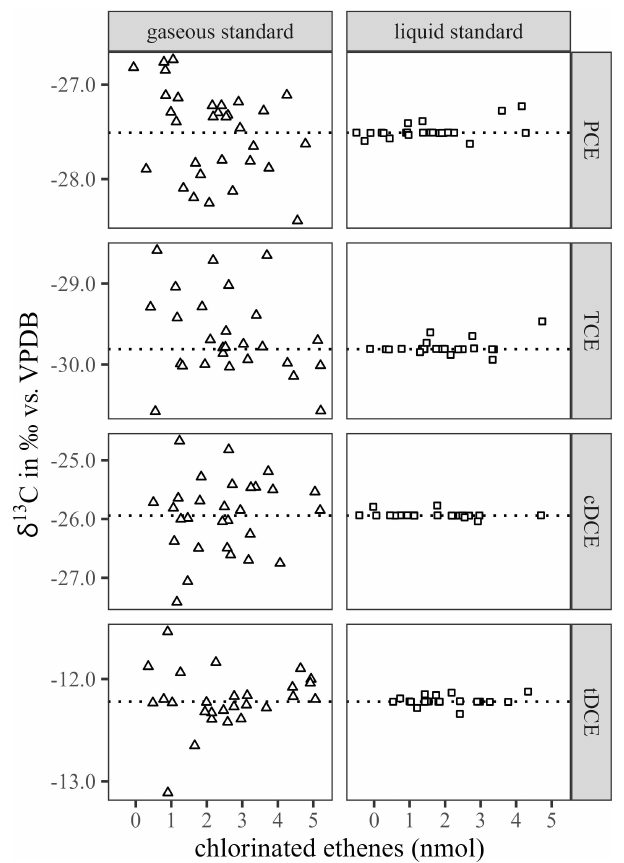
Figure 2. Comparison of δ 13 C values obtained from sorption tubes loaded with either gaseous or dissolved calibration standard aliquots (nmol) for PCE, TCE, cDCE and tDCE. The dotted lines indicate the set values for δ 13 C.